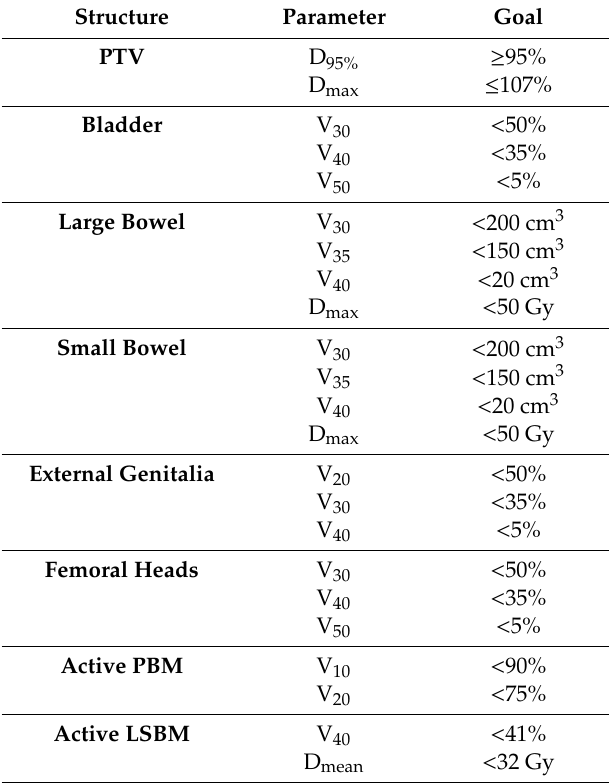
Table 1. Dose constraints employed in the optimization process during treatment